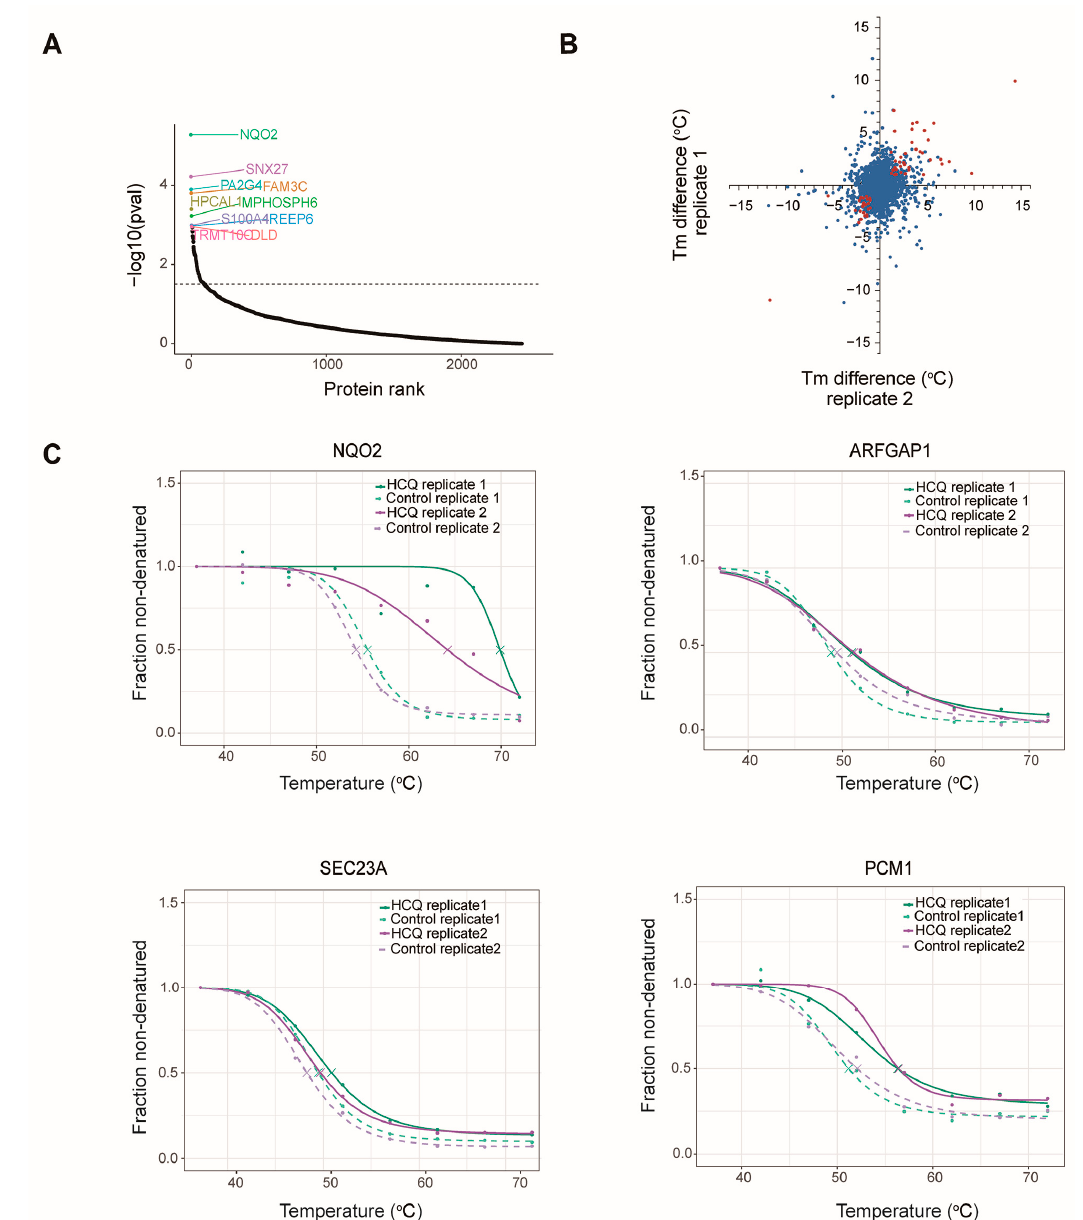
Figure 7. The potential binding proteins of HCQ. ( A ) Ranked proteins according to the p -value. A total of 2567 proteins contained sufficient data points for the analyses and 75 of them had p -values lower than 0.05. ( B ) Distribution of the proteins according to △ Tm in two replicates; blue: total proteins in two replicates; red: proteins with p -values lower than 0.05 and | △ Tm| higher than 1. ( C ) Thermal melt curves of the representative proteins NQO2, SEC23A, PCM1, and ARFGAP1.